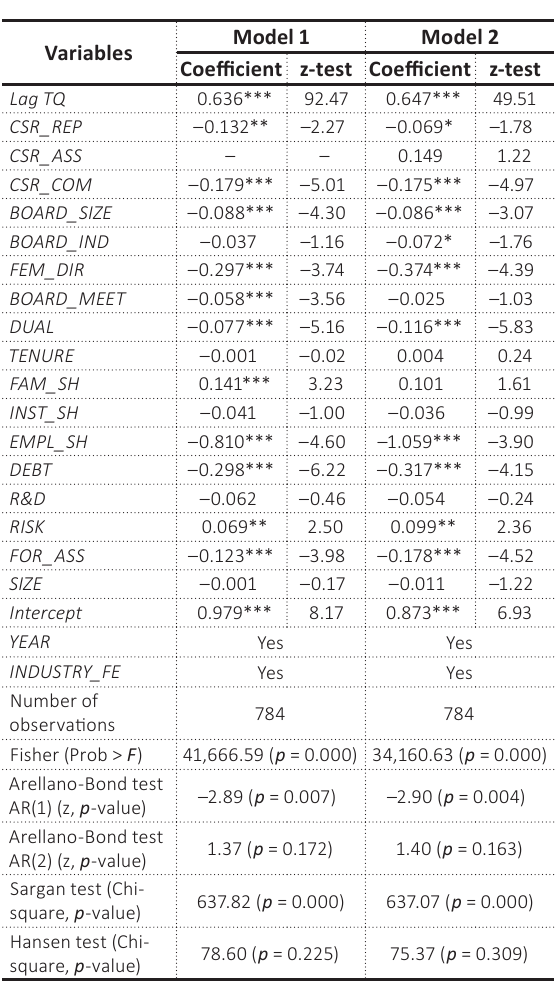
Table 2. Regression of Tobin’s q on CSR